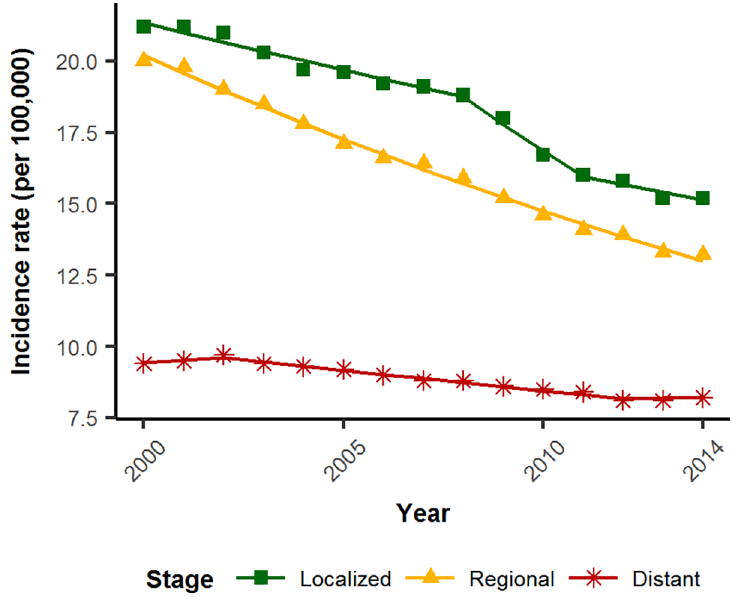
Fig 2. The incidence rate of distant CRC is decreasing much more slowly than non-distant disease. Green squares, localized; yellow triangles, regional; red stars, distant. Incidence rates are expressed per